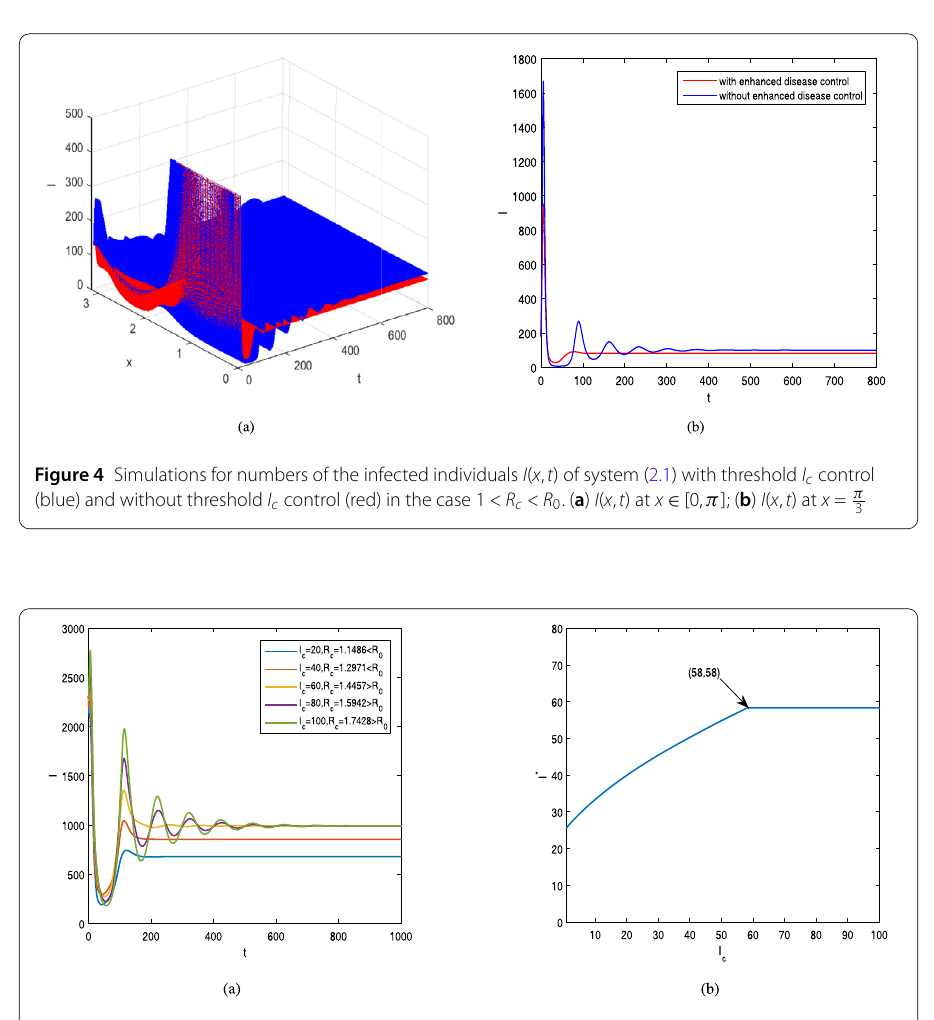
∗ ∗ ∗ ∗ 1 of E 1 or I 2 of E